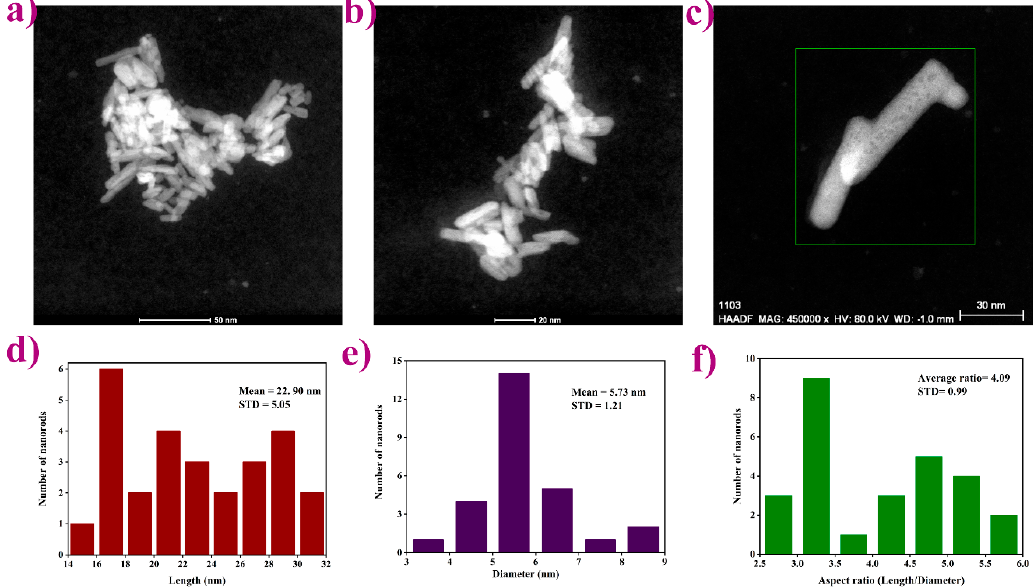
Figure 3. Transmission electron microscopy images showing: ( a – c ) anisotropic rod-like shape particles with an aggregation tendency; ( d – f ) average length/diameter/aspect ratio histograms.